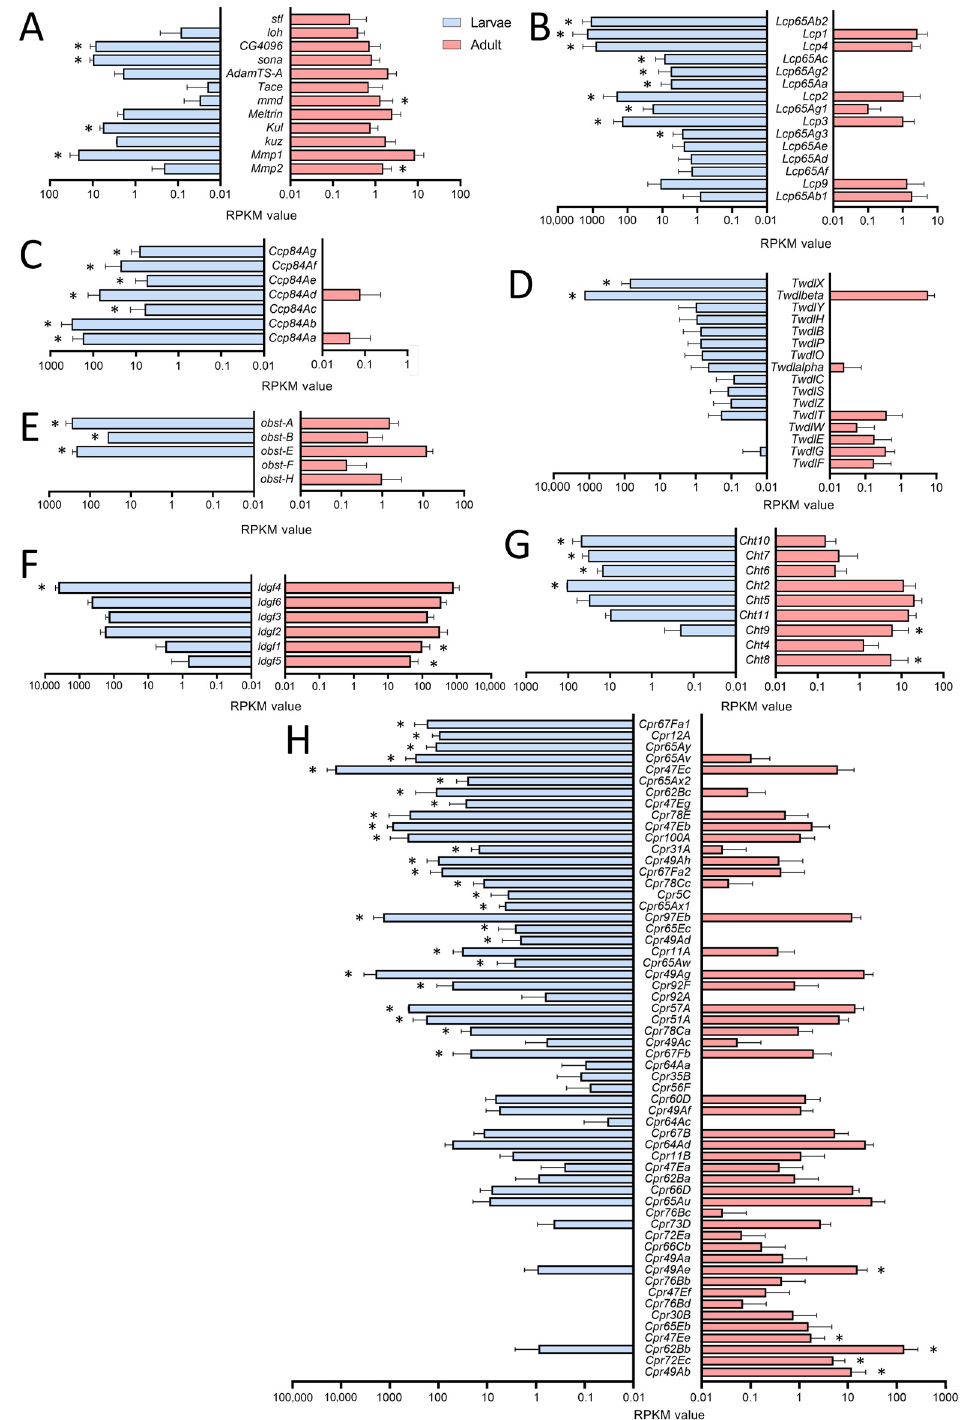
Figure 3. Cuticle-, chitin- and ECM-associated genes in larval and adult trachea. ( A – H ) Bar charts showing the Reads per kilobase of transcript per million mapped reads (RPKM) values compared between larval (blue) and adult trachea (red). In ( A ), genes coding for metalloproteinase; in ( B ), those coding for Larval Cuticle Proteins ( Lcp ); and in ( C ), those of the Ccp family are shown. ( D ) shows members of the Tweedle ( Twdl ) family, ( E ) those of the obstructor ( obst ) group, ( F ) members of the imaginal disc growth factor ( ldgf ) family, ( G ) those of the Chitinase ( Cht ) family, and ( H ) members of the cuticular protein ( Cpr ) group. Asterisks indicate a differential gene expression based on the RNA-Seq analysis. Bars show mean with SD, n = 4.